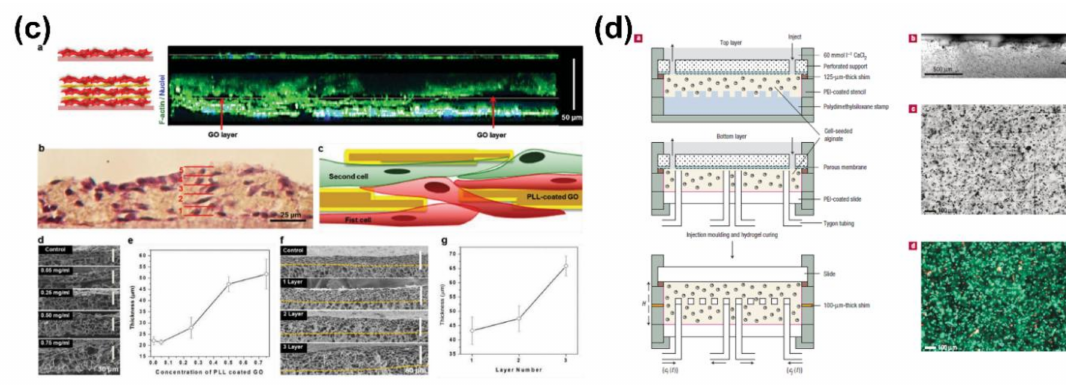
Figure 7. ( a ) Schematic illustration of the microfluidic LbL approach used to create 3D hierarchical systems with matrices and cells; ( b ) 3D images reconstituted from stacks demonstrate a two- or three-layer structure; ( c ) confocal cross-sectional images of the control group (top) and the 3 layer tissue constructs (bottom) after 2 days of culture. Hematoxylin and eosin stain images of 3 layer fibroblasts. Schematic illustration of the cross-section of the 2 layer construct. SEM images showing the cross-section and the thickness of 1, 2 and 3 layer constructs fabricated with various concentrations of poly- L -lysine-coated graphene oxide as interlayer films; ( d ) fabrication of cellular microfluidic scaffolds including the fabrication process and its resultant microstructures. Reprinted from [5,7,106] with permissions from Nature Publishing Group, Elsevier, and